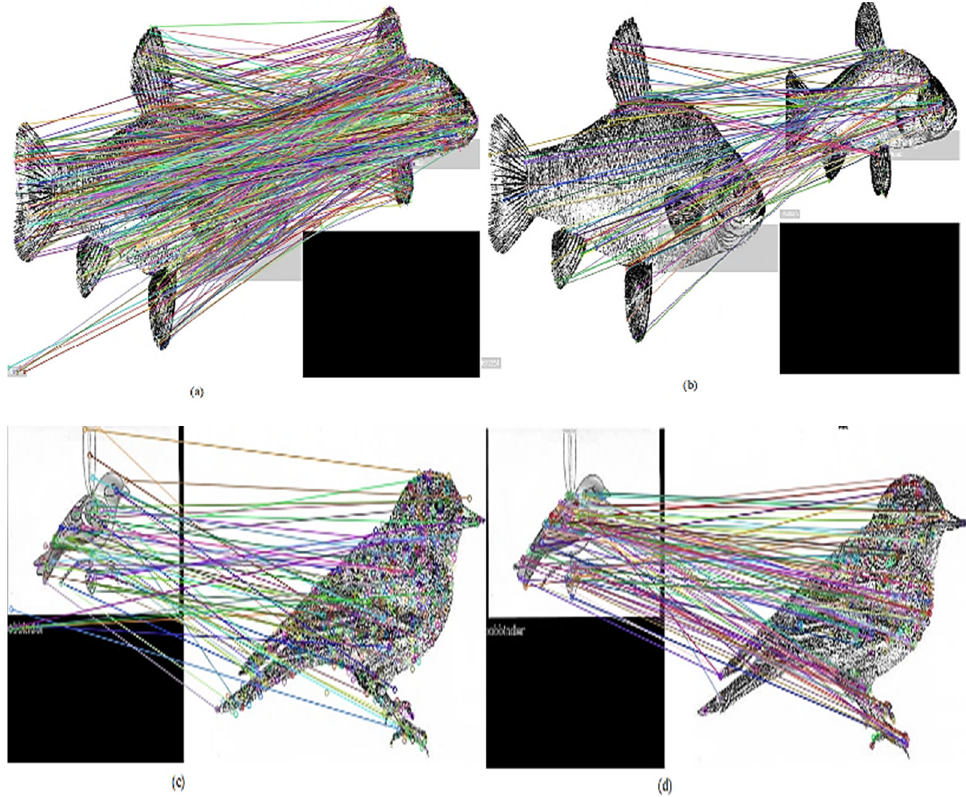
Figure 9. Matched points of ( a ) 1st pair for SIFT, ( b ) 1st pair for ORB, ( c ) 2nd pair for SIFT, and ( d ) 2nd pair for ORB [42].